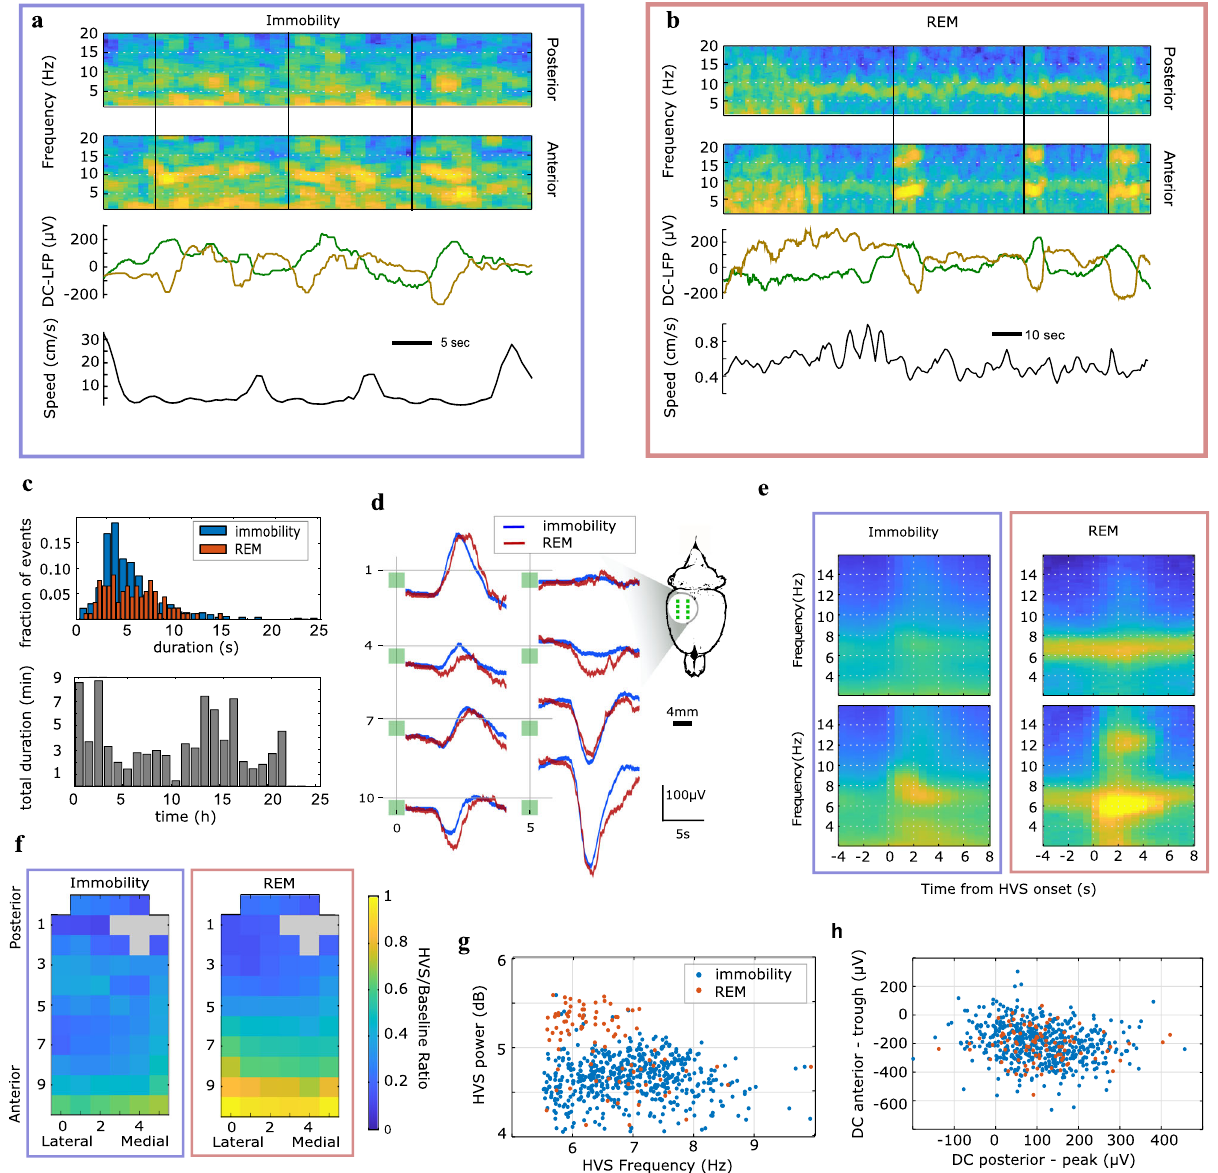
Fig. 6 Topography of AC and DC dynamics associated with high-voltage spindles. a , b examples of HVS events during immobility ( a ) and REM sleep ( b ). Spectrograms at posterior (top) and anterior (middle) positions on the array visualize dynamics of HVS (vertical lines at onsets) and ongoing oscillatory dynamics (low-frequency synchrony in IMM, theta oscillation in REM). Bottom two panels show DC LFP signals from posterior (green) and anterior (brown) positions on the array and head speed. c Distribution of duration of single HVS events for immobility and REM (top) and total hourly duration of HVS across recorded period (bottom). d Average DC LFP traces triggered on HVS onset during immobility and REM sleep (channels arranged as in Fig. 2g- left, inset showing anatomical localization of DC ECoG recording sites). e Average AC LFP spectrograms triggered on HVS onset during immobility (left) and REM sleep (right). The spectrograms at posterior (top) and anterior (bottom) positions on the array contrasting spectral content associated, respectively, with theta (posterior) and HVS (anterior) oscillations. Pseudo-color, spectral power (a.u.). f Topographic maps of change, relative to baseline, in HVS power at peak oscillation frequency during immobility (left) and REM sleep (right). g Distributions of power and peak frequency of individual HVS during immobility (blue) and REM sleep (red). h Distribution of DC fl uctuation magnitude at posterior lateral and frontal medial derivations for single HVS during immobility and REM (color code as in g